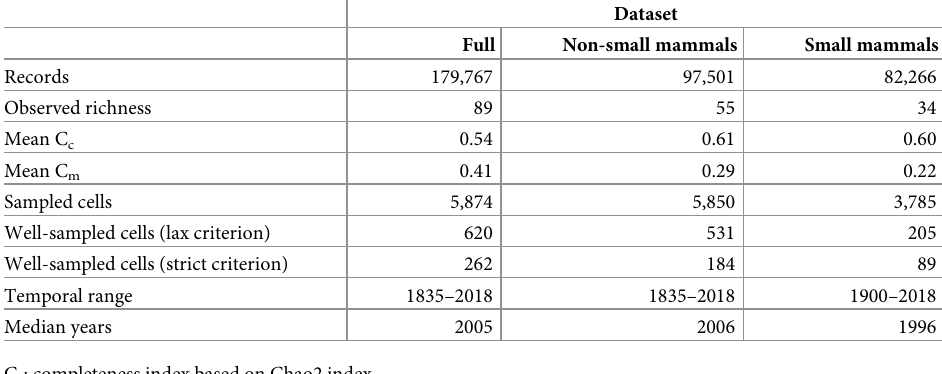
Table 1. Summary of 10-km cells sampled across the Iberian Peninsula for full, non-small mammals (Lagomor- pha, Artiodactyla, Carnivora, Chiroptera and Erinaceidae) and small mammals (Rodentia and Soricidae)